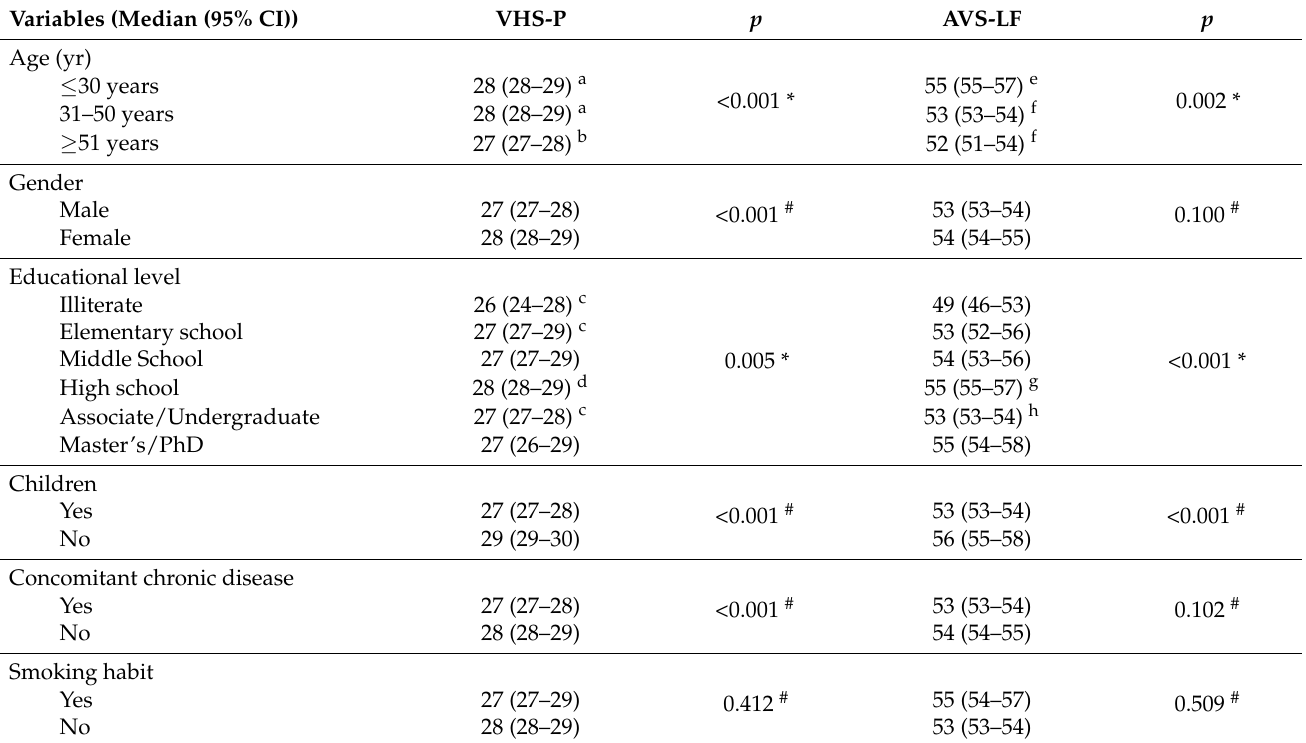
Table 4. Comparisons of VHS-P and AVS-LF scales according to the sociodemographic characteristics of the